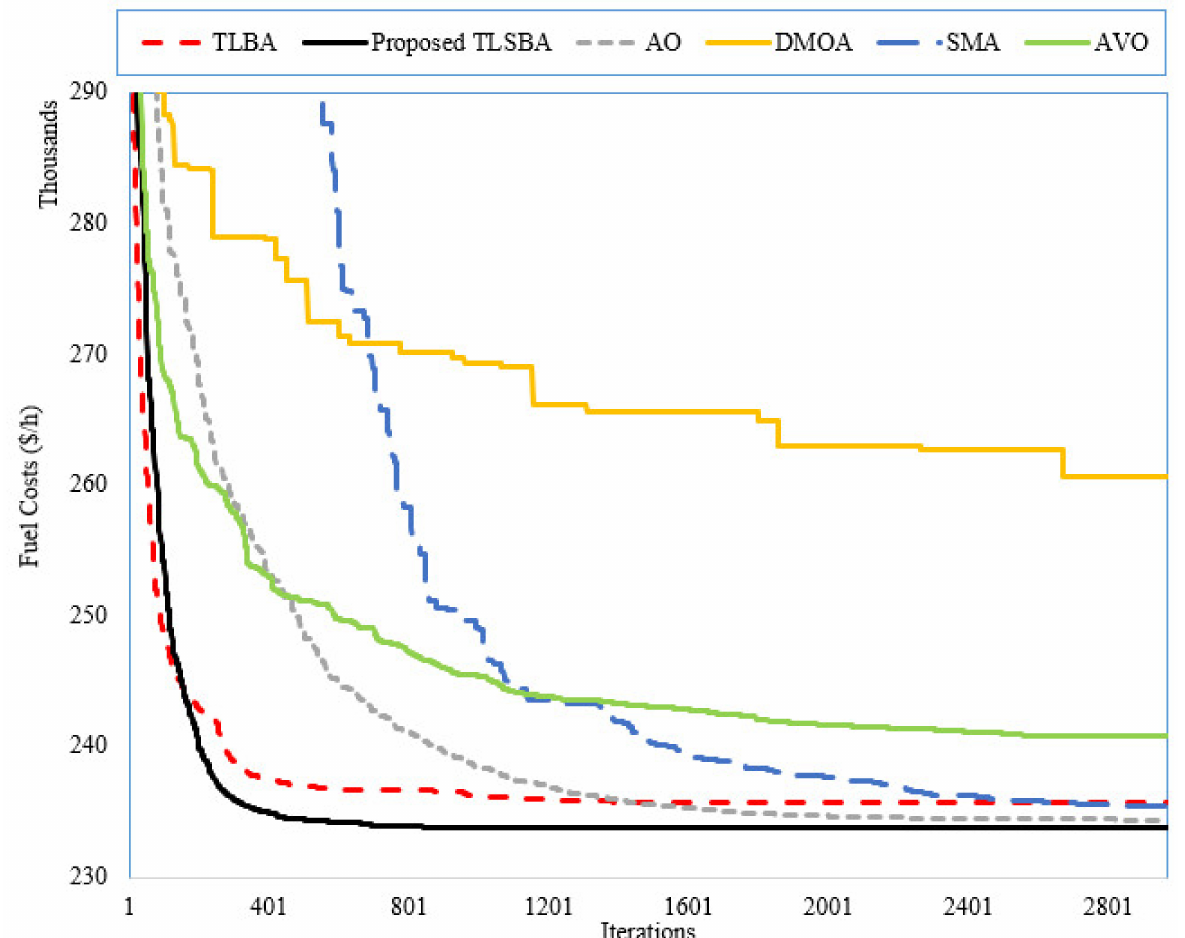
Figure 16. Convergence rates of the compared algorithms for test system